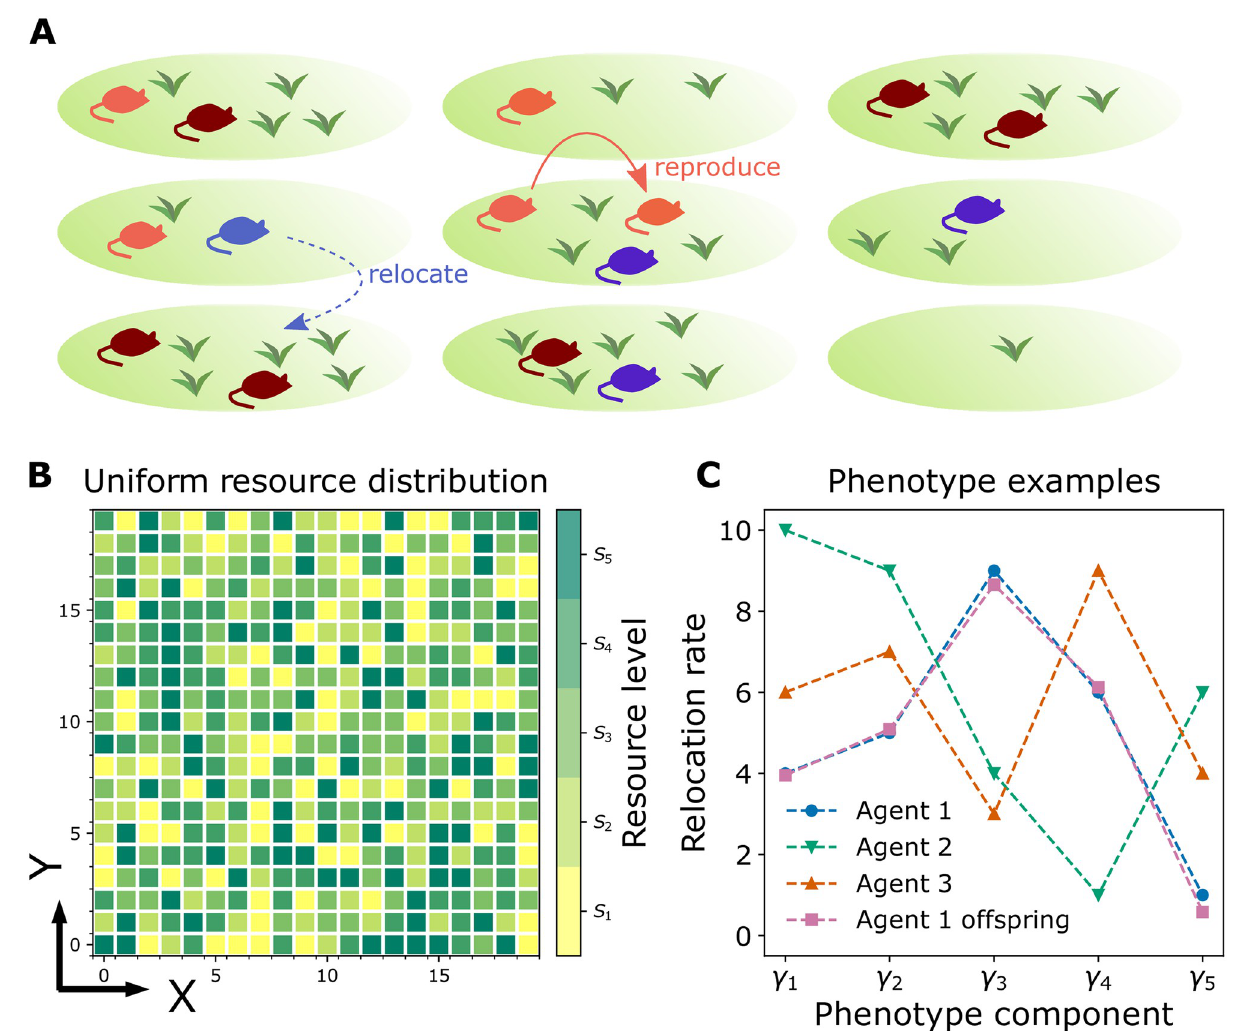
Fig 1. Schematic diagram of the mechanistic evolutionary dynamics model. A. The model consists of a population of agents foraging in an environment with a random distribution of resources, in which each agent can either asexually produce an offspring (as shown by the orange arrow) or relocate to one of the vertical or horizontal neighboring locations (as shown by the dashed blue arrow). Different colors here distinguish agents with different phenotypes. B. The environment is a two dimensional discrete lattice on which each location has a predetermined resource level S , k 2 {1, 2, k 3, 4, 5}, chosen from a distribution (a discrete uniform distribution shown here). A 20 × 20 subset of the environment is shown here. Each site on the lattice is colored according to its resource level S . Agents at locations with resource level S will reproduce at a birth rate b . C. Each agent has a k k k phenotype vector with 5 components, corresponding to the relocation or hopping rates of the agent at 5 different resource levels. These components are initially chosen randomly for each agent and are shaped over the course of evolution. In the example shown here, agent 2 has a relocation rate γ 3 � 4 when it is at a site with resource level S 3 . In the agent-based stochastic model, an offspring inherits a noisy copy of its parent’s phenotype, as shown here for the phenotypes of agent 1 and its offspring.